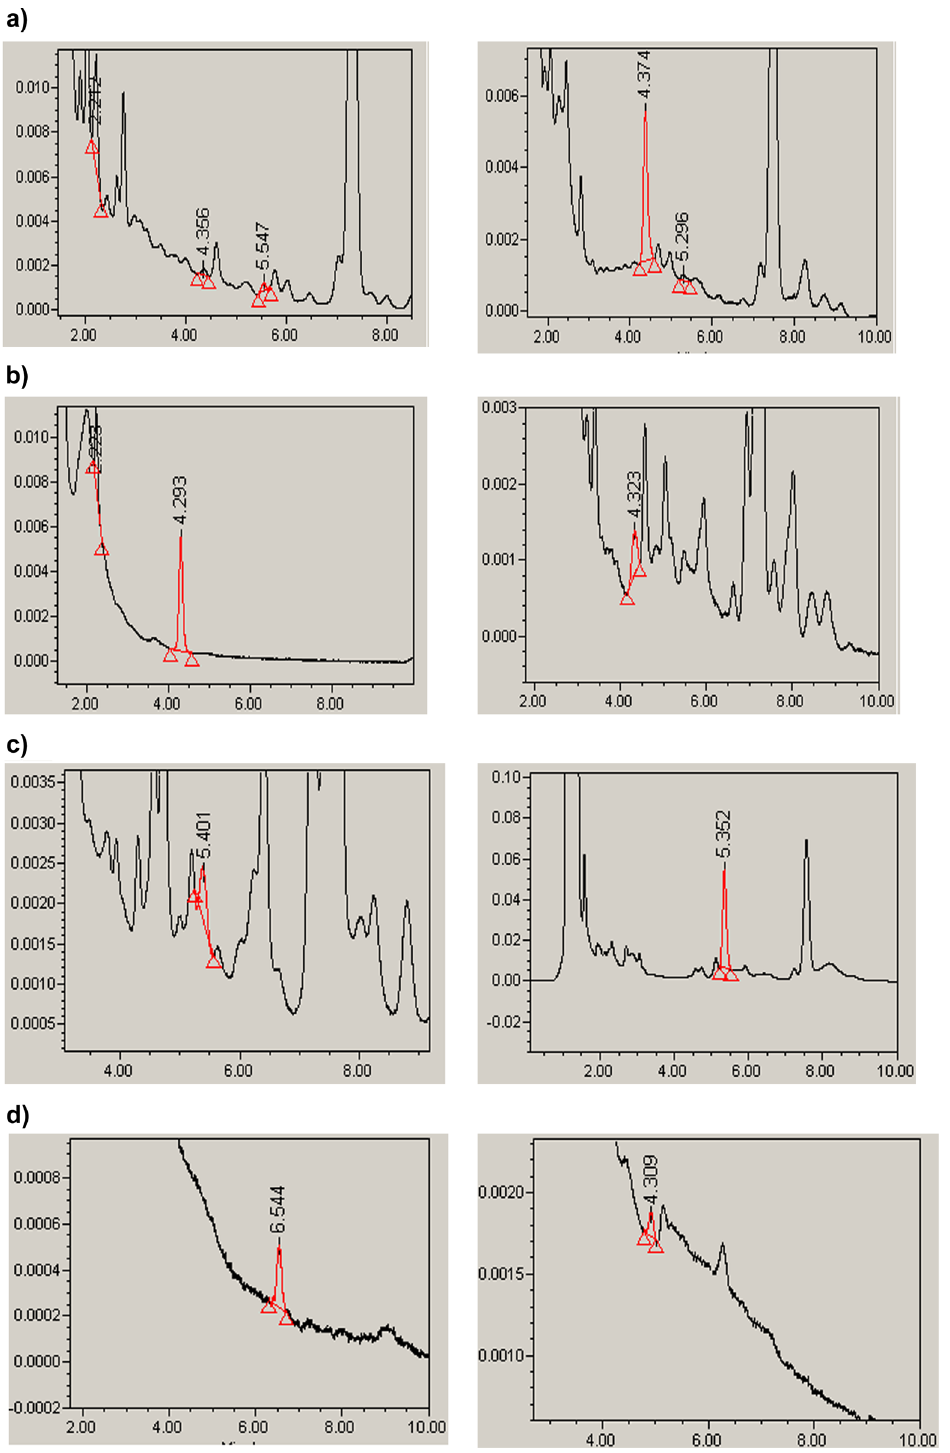
Figure 3: Typical HPLC chromatograms of selected samples of each meat category showing the estrogen found in each sample. ( a ) Chicken category: Burger chicken ( 5.5 µg/g E4, 0.50 µg/g E2 ) and Mortdella chicken ( 225 µg/g E4, 0.40 µg/g E2 ) . ( b ) Beef category: Burger ( 250 µg/g E4 ) and Mortdella ( 70 µg/g E4 ) . ( c ) Sheep category: Muscles ( E2 ) and Burger ( 3.39 µg/g E2 ) . ( d ) Camel category: Muscles ( 2.40 µg/g E1 ) and Muscles ( 3.36 µg/g E4 )